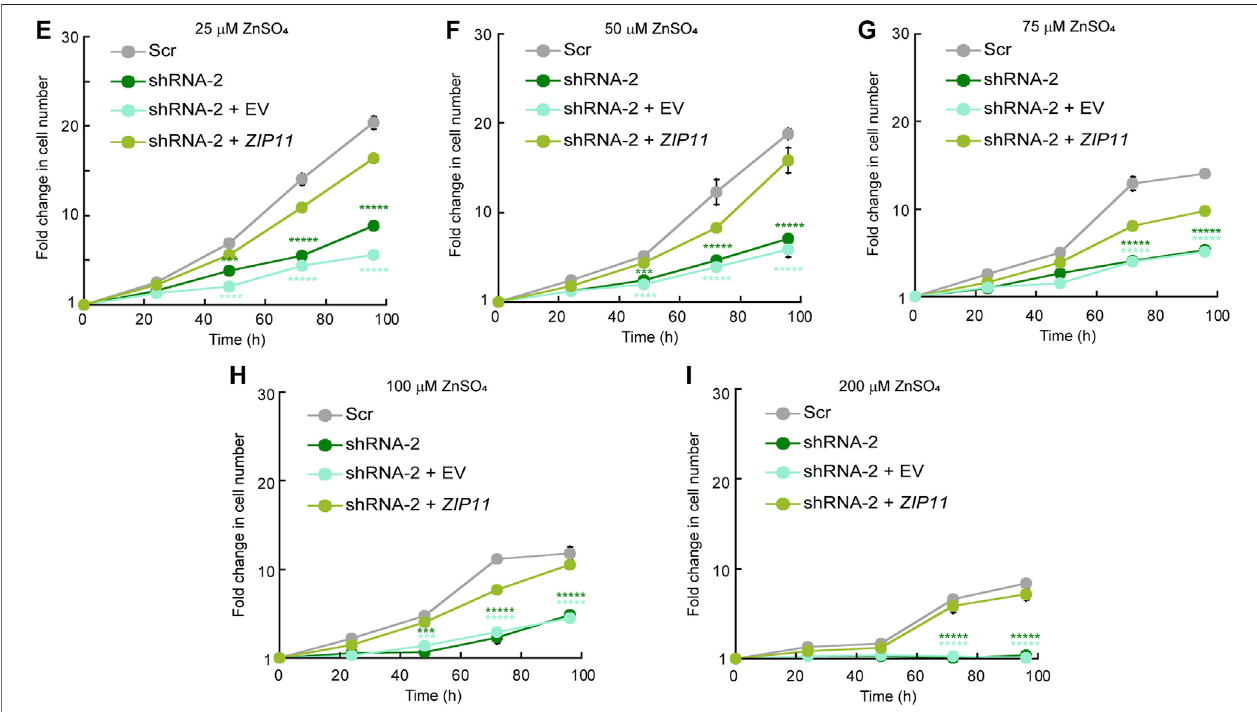
FIGURE 5 | Reintroducing ZIP11 in HeLa cells restores growth, nuclear Zn levels and resistance to elevated levels of Zn. (A) Representative immunoblot (left) and quanti fi cation (right) of ZIP11 levels in HeLa proliferating cells. The cells expressing the shRNA2 against ZIP11 targeting the UTR region of ZIP11 were used for reconstitution of phenotypes experiments. Immunoblots against MTF1 shows increased expression of its metalloprotective transcription factor in ZIP11 KD cells. GAPDH was used as loading controls. (B) Cell counting assay of proliferating cells transduced with scrambled shRNA (shRNA Scr), or ZIP11 shRNA-2 expressing exogenous ZIP11 or empty vector (EV). (C) Representative confocal micrographies of ZIP11 (red) and Golgin-97 (green) showing the enhanced expression and perinuclearandvesiculardistributionofZIP11inHeLacellsKDfor ZIP11 (shRNA-2) andstablyexpressingZIP11ortheempty vector(EV). NucleiwasstainedwithDAPI. Bar = 10 µm. (D) Distribution of the Zn levels in proliferating HeLa cells. Cells stably expressing Scr, and shRNA-2 against ZIP11 reconstituted with ZIP11 or the empty vector were allowed to grow for 48 h and subcellular fractions were obtained using the REAP protocol. Whole cell (left) cytosolic (middle) and nuclear (right) Zn content determined byAAS (Itzhak et al.,2016; Gordonet al., 2019a; Tavera-Montañez et al., 2019). (E – I) Analysesof Znresistance upon reintroduction ofthe ZIP11 gene. Cell counting assay of proliferating cells transduced with scrambled shRNA (shRNA Scr), ZIP11 shRNA2 expressing the transporter gene or an empty vector, cultured for 96 h with increasing concentrations of ZnSO4. (E) 25 µM. (F) 50 µM. (G) 75 µM. (H) 100 µM. (I) 200 µM. The data represents the mean ± SE for three independent experiments. ***** p < 0.00001.For all samples, data are the mean ± SE of three independent biological replicates. * p < 0.05; ** p < 0.01; ***** p <